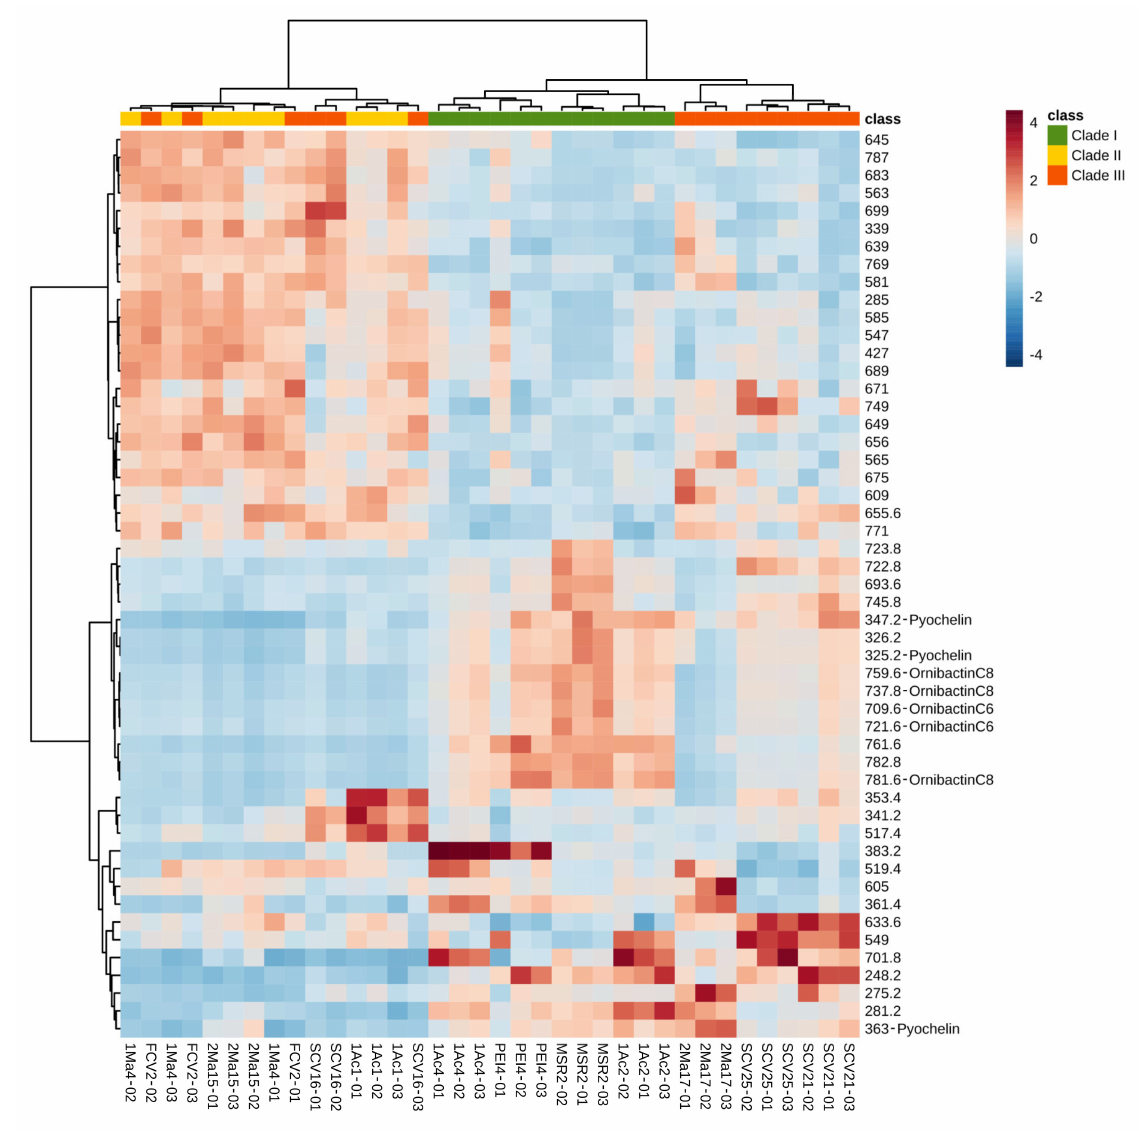
Figure 5. Metabolic heat map based on DIESI-MS data of 50 discriminant ions selected by using the random forest model. The Euclidean distance and Ward’s algorithm were used for the hierarchical classification of rhizosphere Burkholderia sensu lato strains, listed on the bottom end of the chart, based on the respective abundance of the discriminant ions selected. Some of these were assigned an identity, as shown for ions corresponding to pyochelin and ornibactin C8 and C6. The colors at the top of the chart are representative of the grouping of the different Burkholderia sensu lato strains: clade I (green), clade II (yellow) and clade III (orange-red). The colored bars (in the blue-red range) indicate the abundance of each metabolite ion, where red indicates higher signal